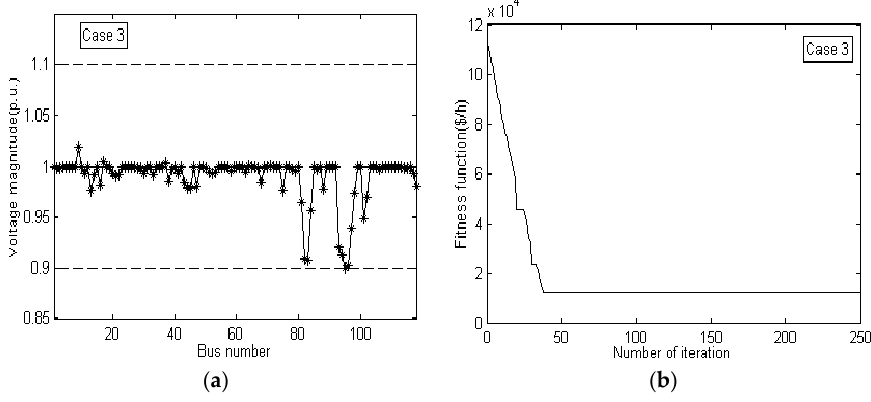
Figure 5. Simulation results for Case 3. ( a ) voltage magnitude in p.u.; ( b ) convergence profile.